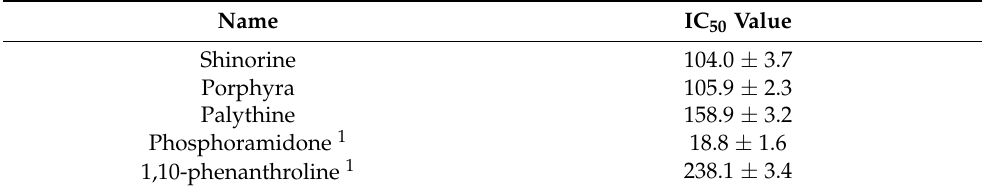
Table 3. Mycosporine-like amino acids (MAA) from marine sources and two standard inhibitors, tested in the collagenase inhibition assay described by Hartmann et al.